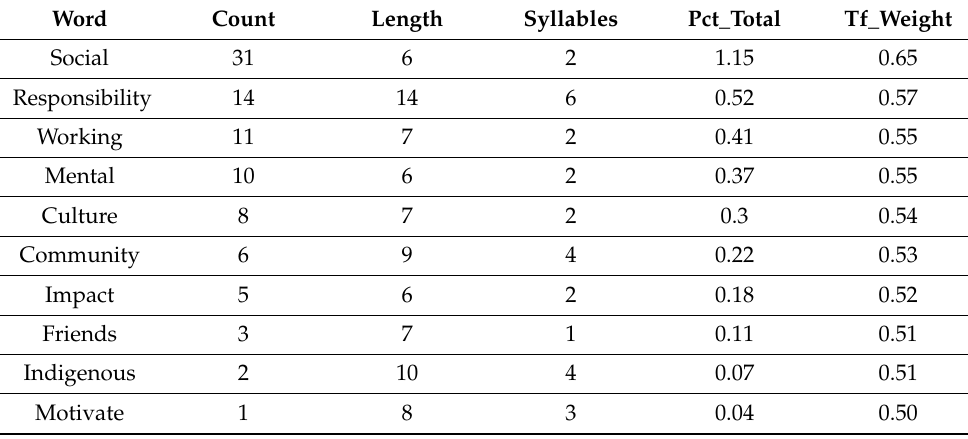
Table 9. Word Frequency Analysis for Blog (Source: Advanced Text